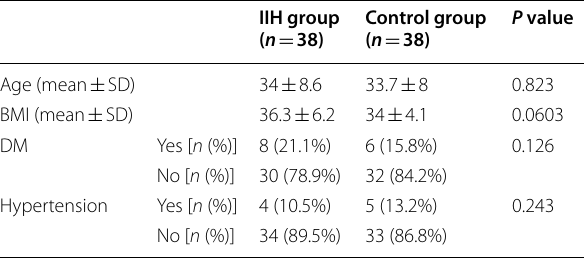
Table 1 Demographic data and comorbidities in IIH patients and control group